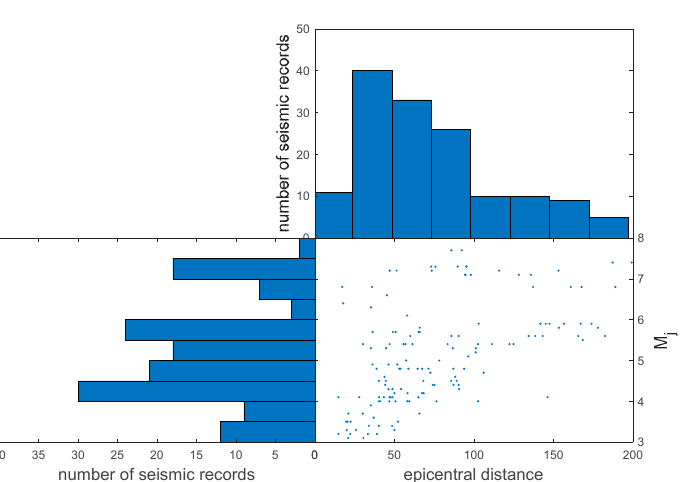
Figure 1. Distribution of the number of earthquake records with selected epicentral distances and magnitudes.